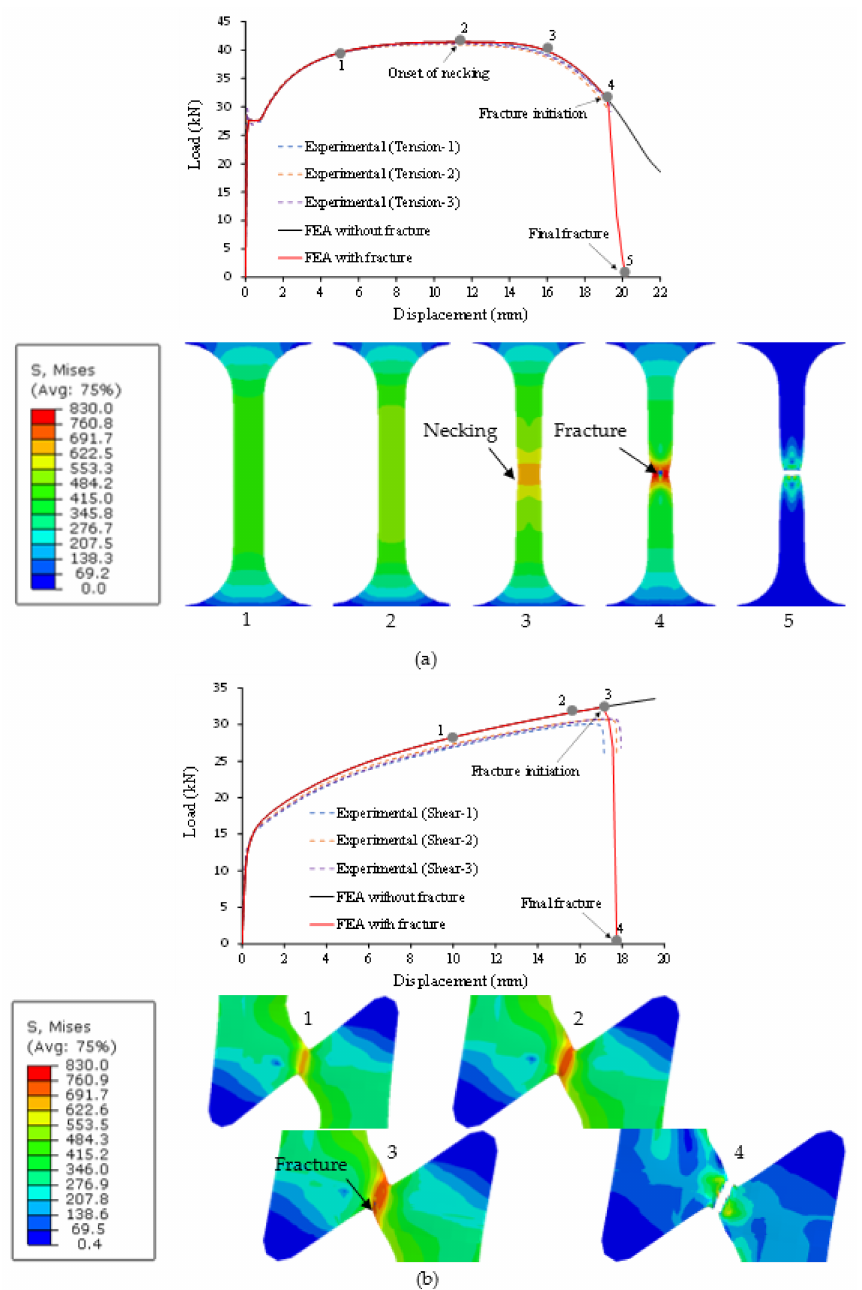
Figure 10. Results of fracture simulation: ( a ) Uniaxial tension specimen; ( b ) In-plane shear